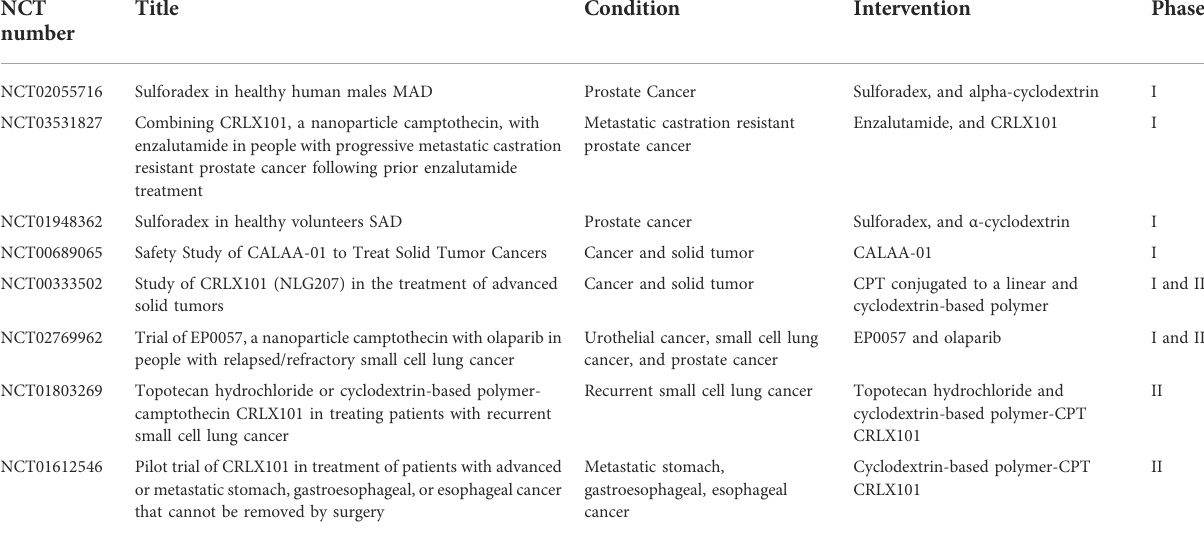
TABLE 2 Current and ongoing clinical trials for chemotherapy using cyclodextrin as